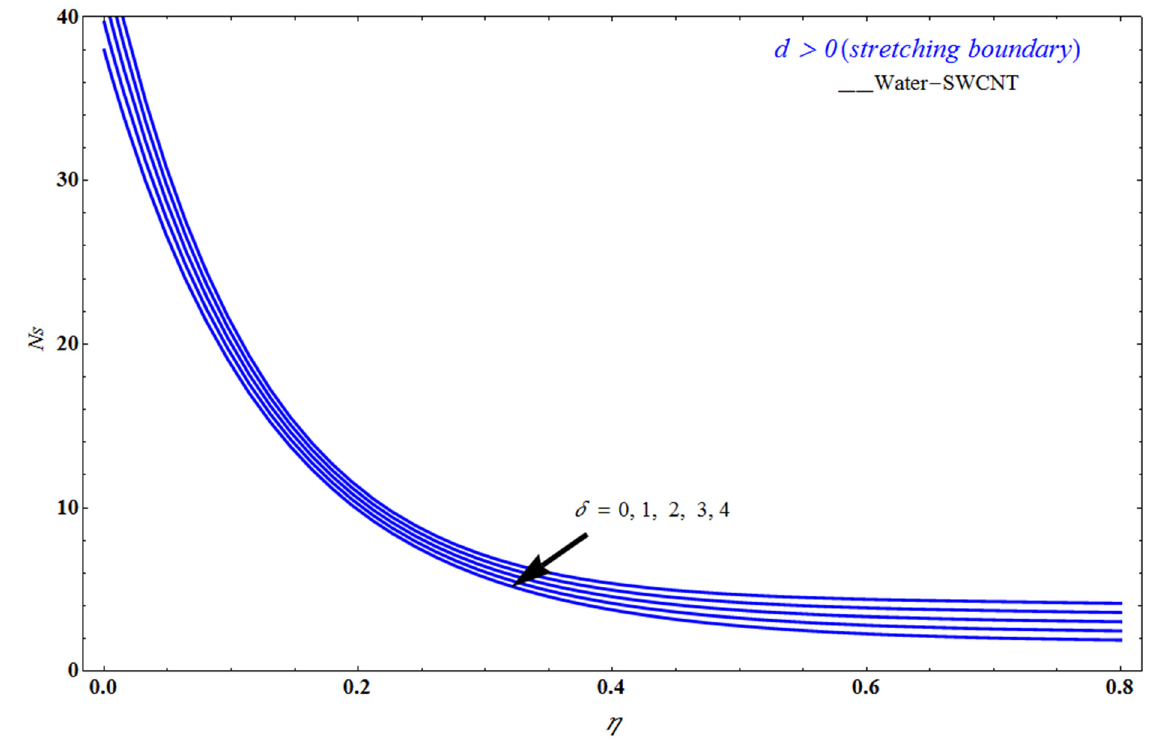
η for several values of